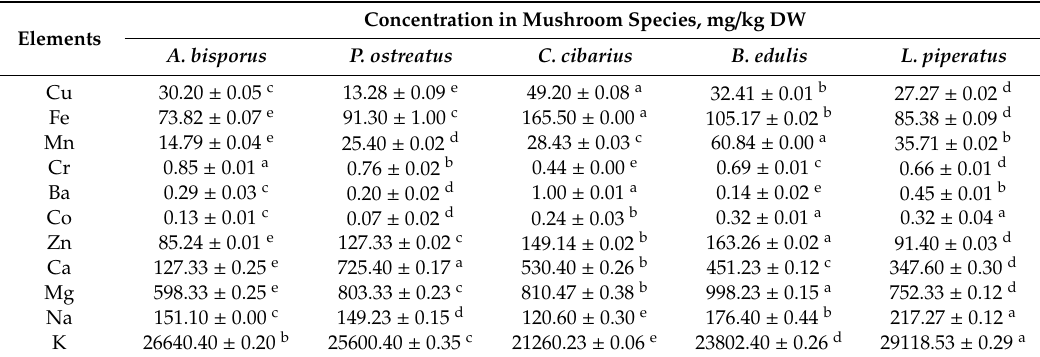
Table 5. Elemental concentration of mushroom